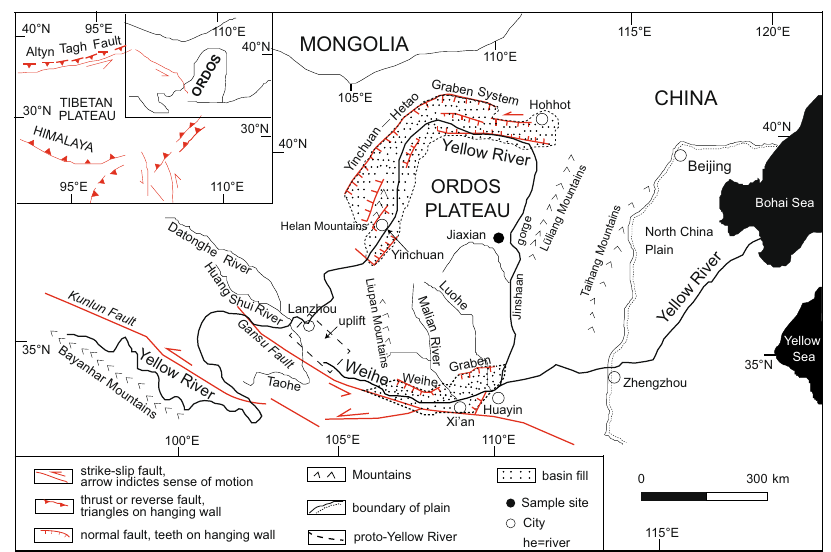
Fig. 2 Structure map of the study area (modi fi ed from ref. 44 ). The inferred uplift area near Lanzhou is indicated by the dashed rectangle.